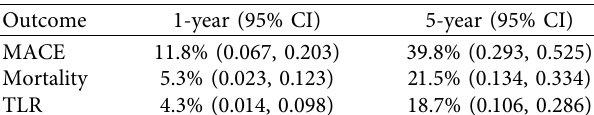
Table 5: Results.